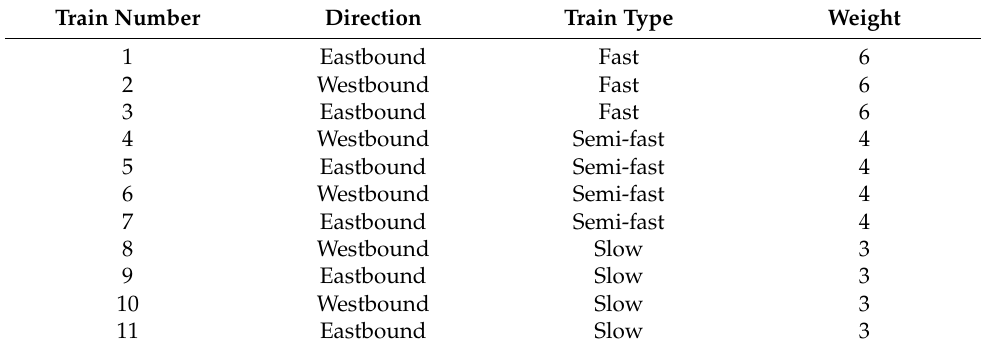
Table 7. Trains in the problem instances.